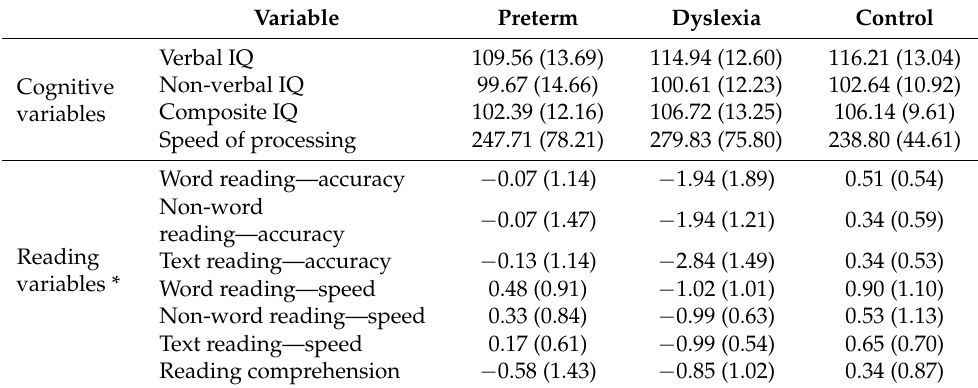
Table 1. Means and Standard Deviations for the Cognitive and Reading